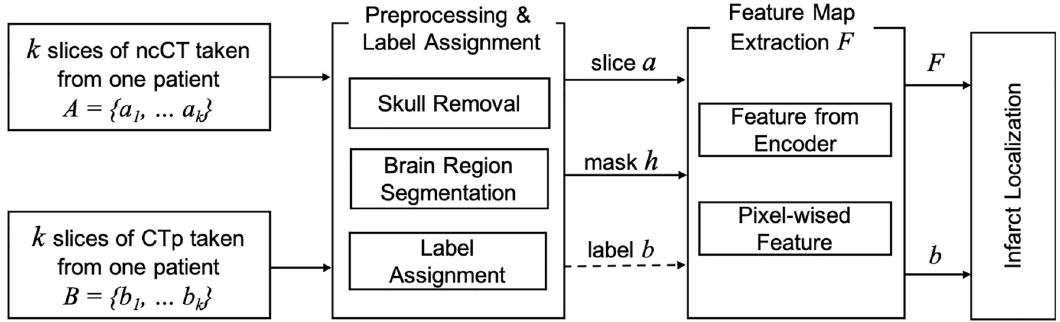
Fig 2. Three basic steps of the proposed model 1) label assignment, 2) feature map extraction, 3) infarct